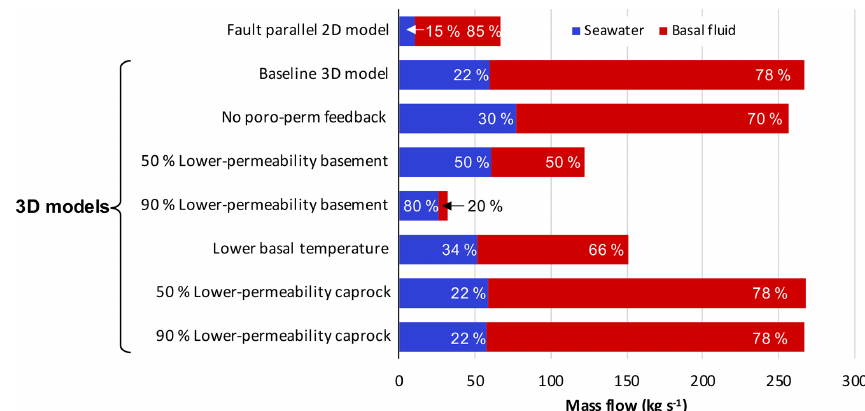
Figure 9. Total discharge to the sea floor from simulations of geothermal convection within the FDZ, differentiating between the contributions of seawater drawn down into the fault-damage zone (FDZ) and basal fluid.